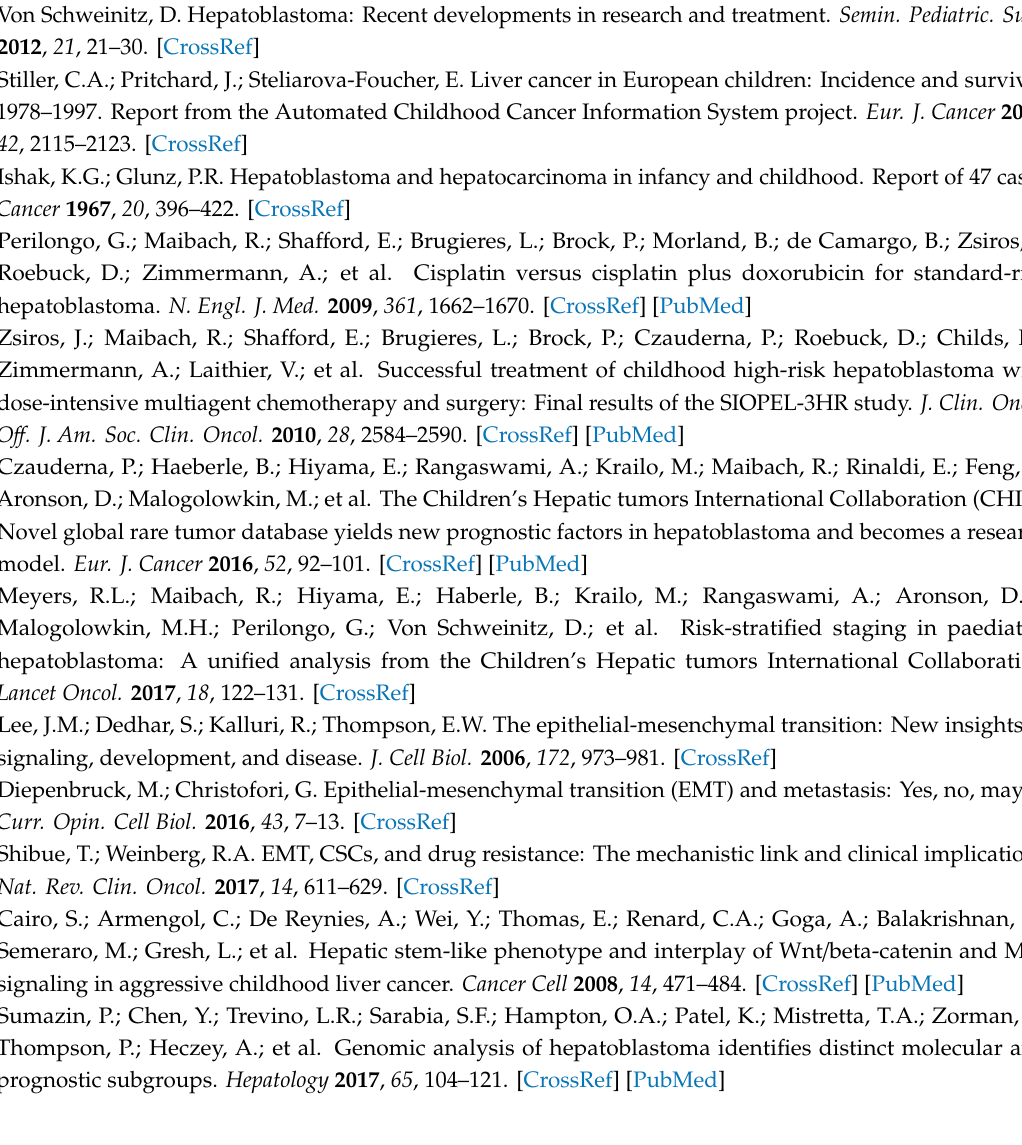
cell lines; Figure S4: Gain- and loss-of-function expression studies of SP8 and FGF8 in liver cancer cell lines; Figure S5: RNA expression of SP8 and FGF8 after MMA treatment; Figure S6: CRISPR-Cas9 interference